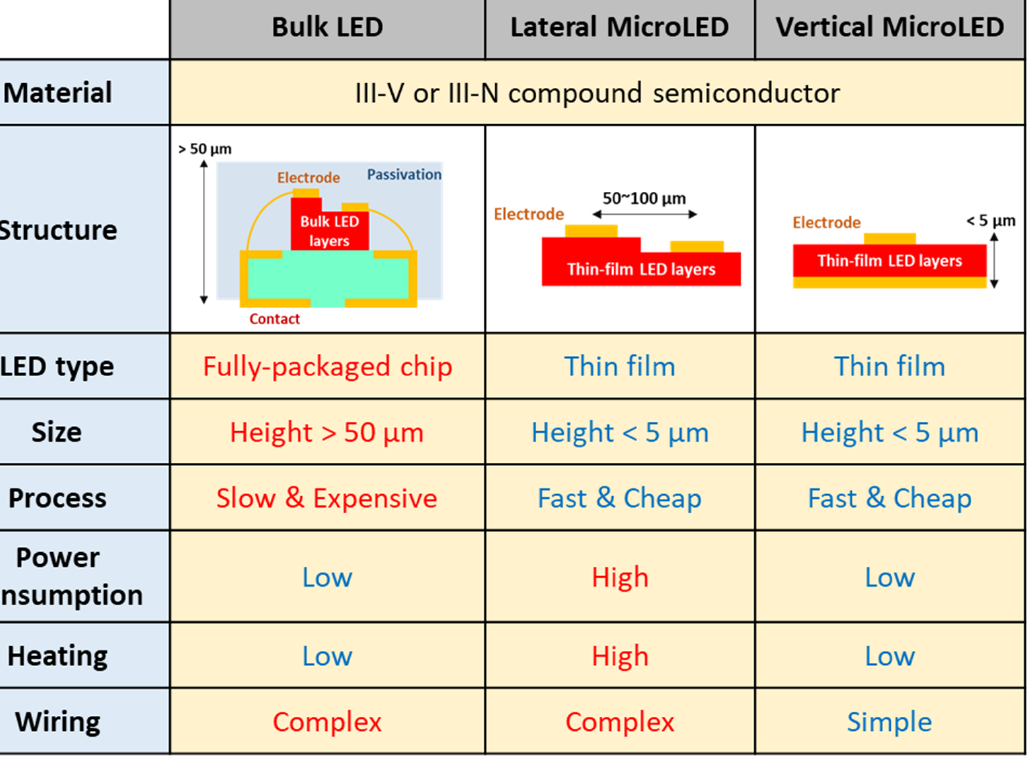
Figure 4. Comparison of bulk LED, lateral-, and vertical-structured µ LEDs; red: disadvantages, blue: advantages).